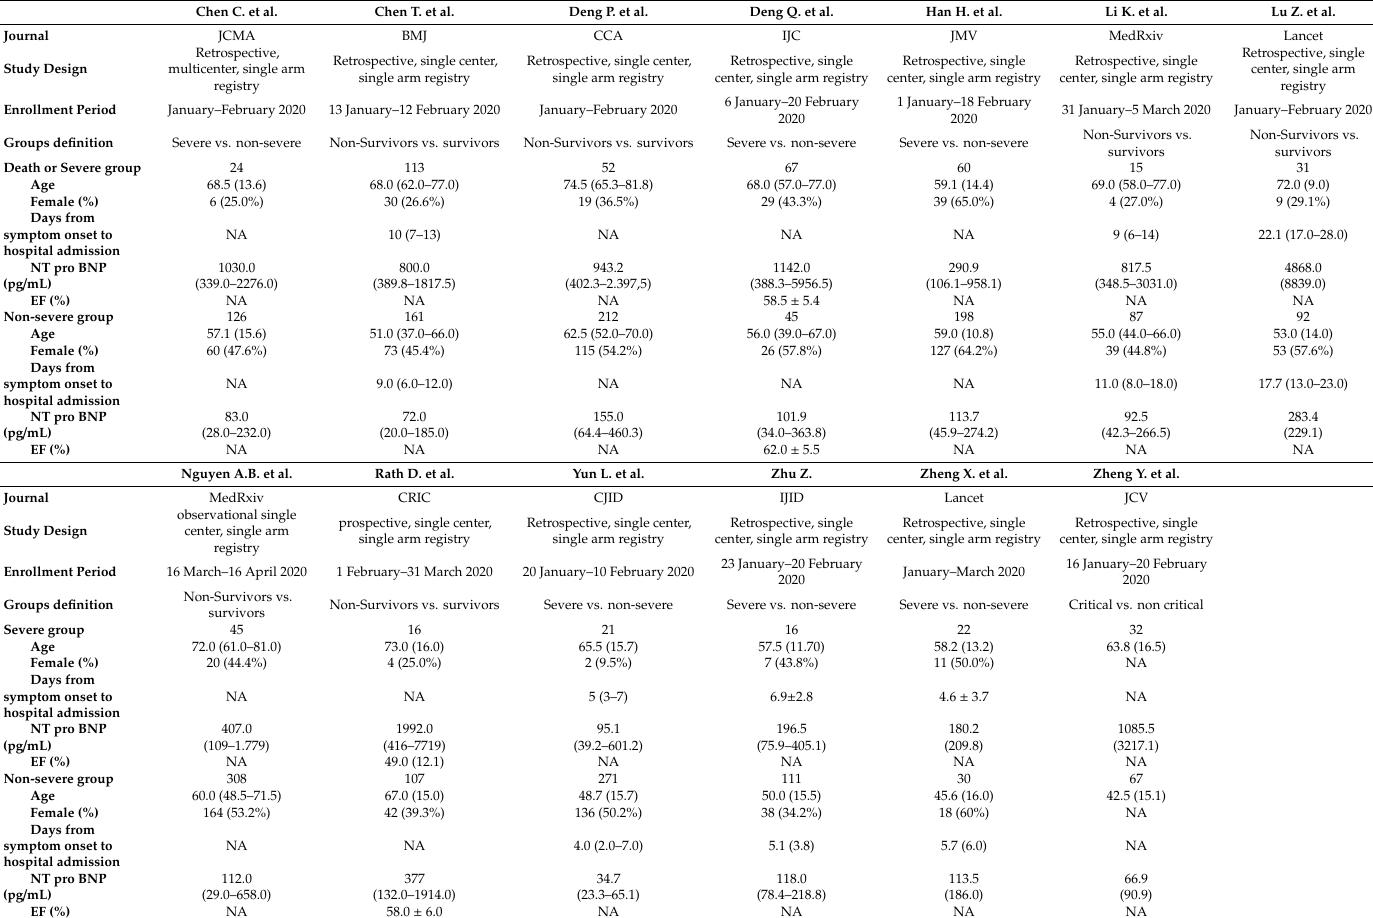
Table 1. Baseline studies’